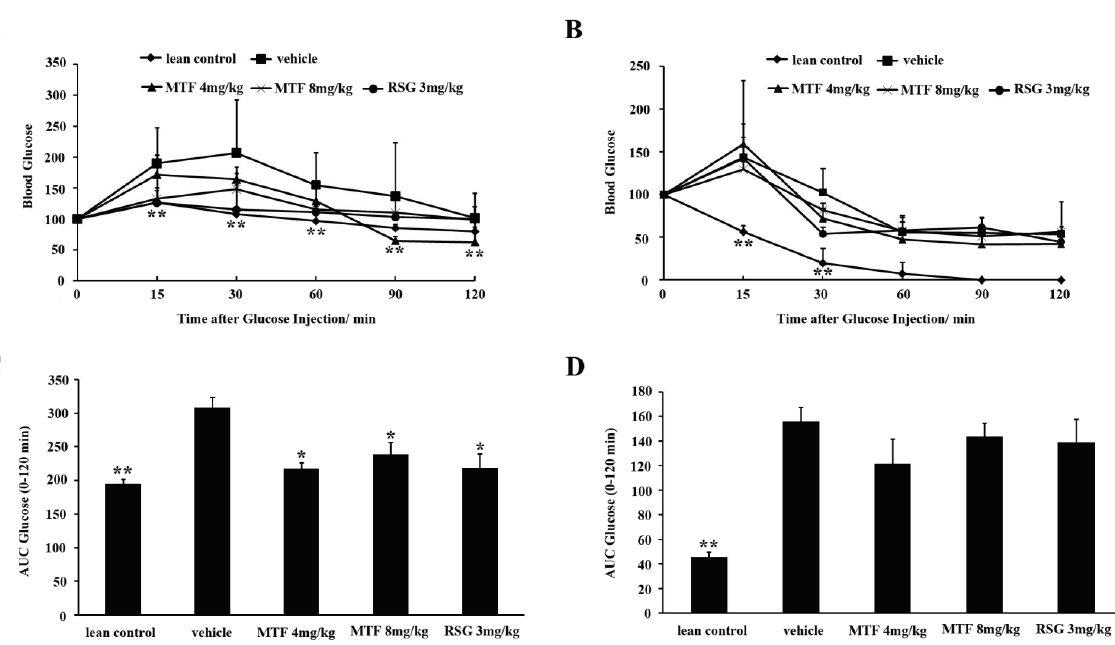
into mice; ( B ) After 10 h of fasting, 0.75 U/kg of insulin was injected intraperitioneally into mice. Blood glucose levels were measured at the indicated times shown in the graph; AUCs for ( C ) OGTT and ( D ) ITT are shown in the graph. Values are the mean ± SD ( n = 8). * p < 0.05; ** p < 0.01 vs.